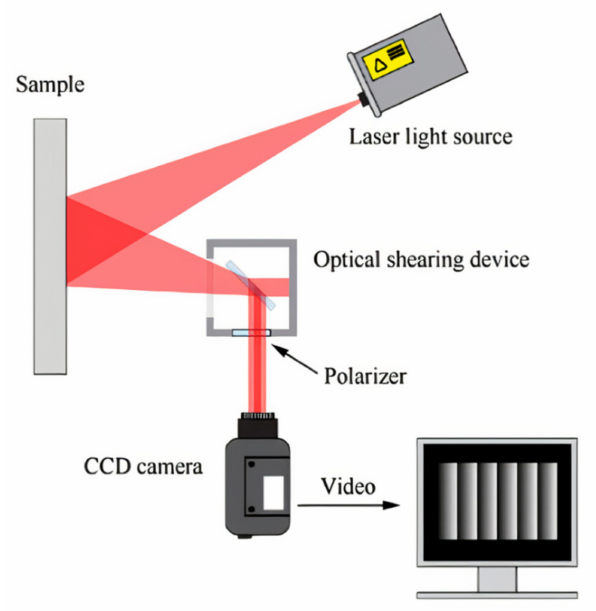
Figure 5. Setup system of laser shearography (LS) [14].